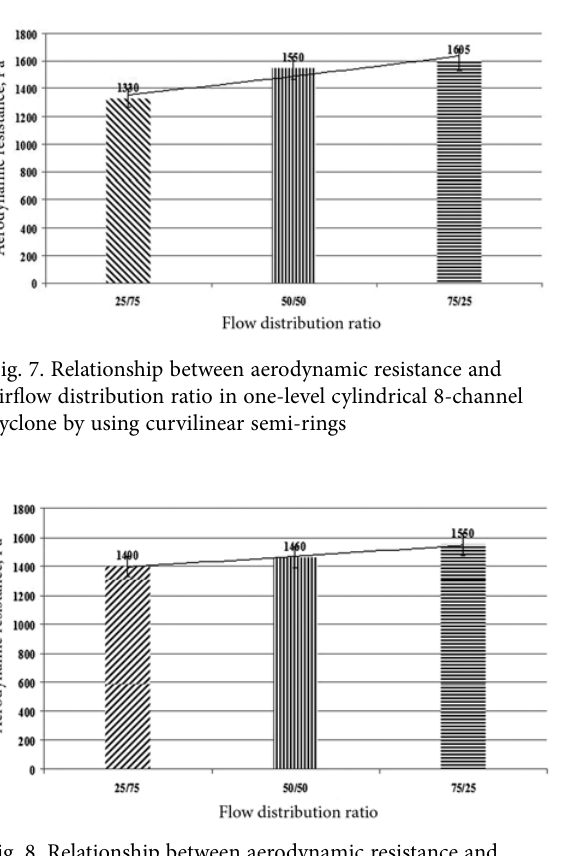
Fig. 8. Relationship between aerodynamic resistance and airflow distribution ratio in one-level 8-channel cyclone when quarter-rings without holes are used